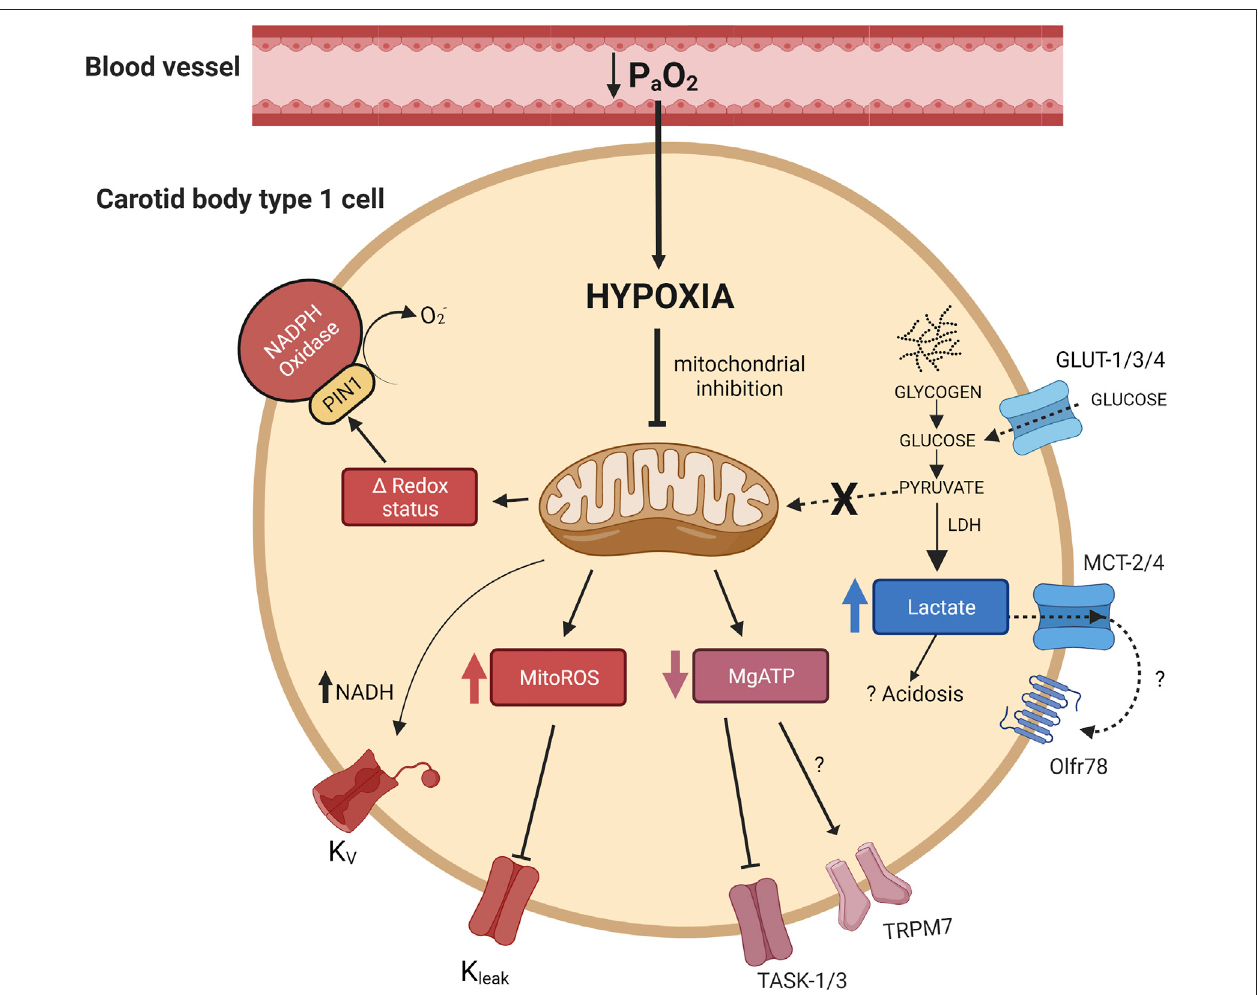
FIGURE 1 | Activation of multiple mitochondrial related signalling pathways in the carotid body type I cell during hypoxia. Hypoxia leads to mitochondrial inhibition whichisproposedtocause:1)anelevationinmitochondrialreactiveoxygenspecies(MitoROS),2)ashiftinmitochondrial/cellularredoxstatus( Δ redoxstatus),3)afallin MgATP and 4) a rise in lactate. Some of these pathways have been shown to directly modify ion channel activity and cause cellular depolarisation. NADH has also been suggested to modify voltage dependent potassium channels. Arrowheads indicate promotion, fl atheads indicate inhibition. PIN1, peptidyl-prolyl cis/trans isomerase; Olfr78, olfactory receptor 78; TASK, TWIK-related acid-sensitive potassium channel; TRPM7, transient receptor potential channel M7; MCT-2, monocarboxylate transporter-2; MCT-4, monocarboxylate transporter-4; LDH, lactate dehydrogenase; K v , voltage dependent potassium channel(s), K leak , potassium leak